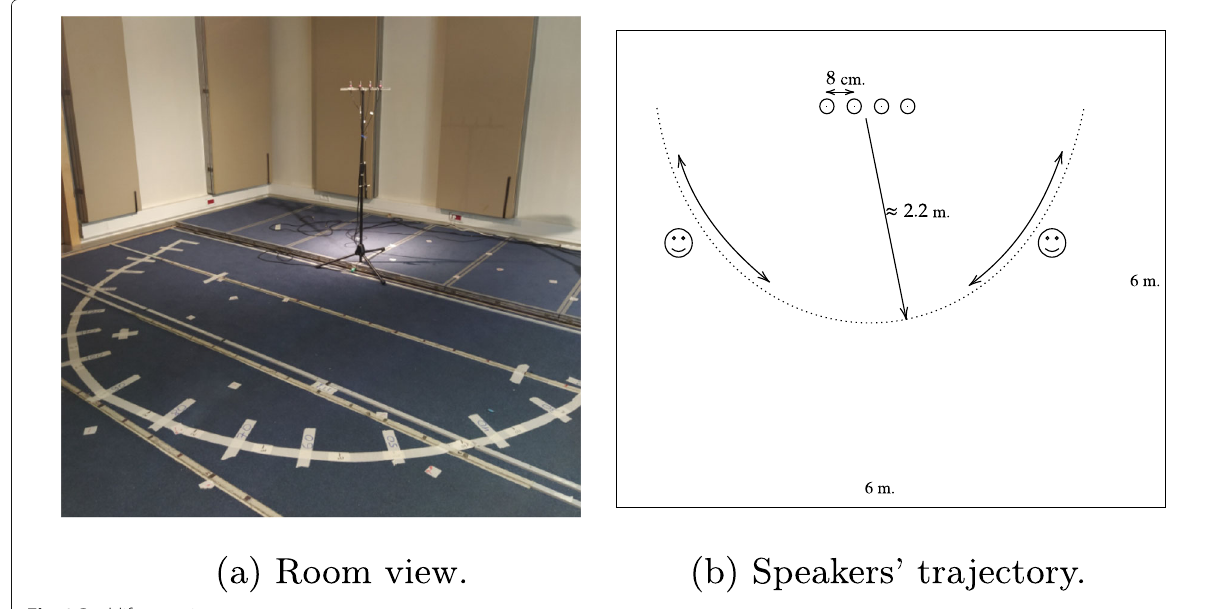
Fig. 2 Real-life experiment setup